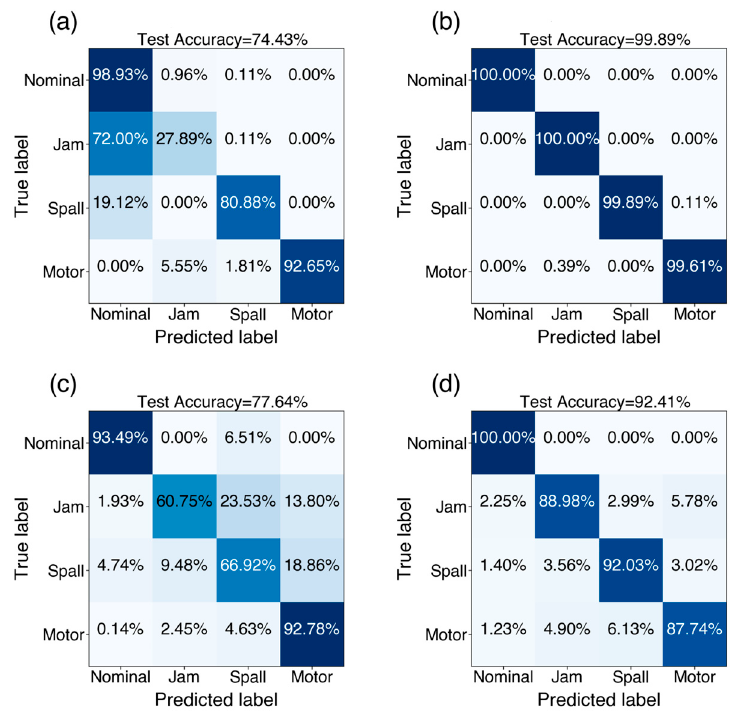
Figure 8. Confusion matrices. ( a ) Task T3d | CNN; ( b ) Task T3d | ETJ; ( c ) Task T1c | CJ; ( d ) Task T1c | ETJ.